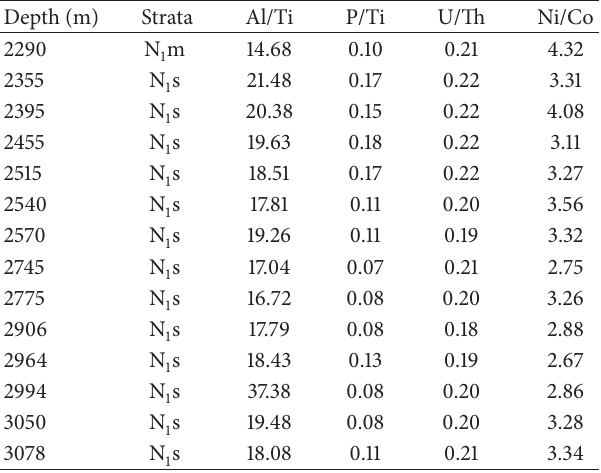
Figure 6: The cross plot showing the relationship between P/Ti ratios and Al/Ti ratios of Miocene source rocks of well BD20-1-1 in the Qiongdongnan Basin. Note: the samples in the chart are from the neritic sea. Table 2: Basic inorganic geochemical parameters for the Miocene marine source rocks of well BD20-1-1 in the Qiongdongnan